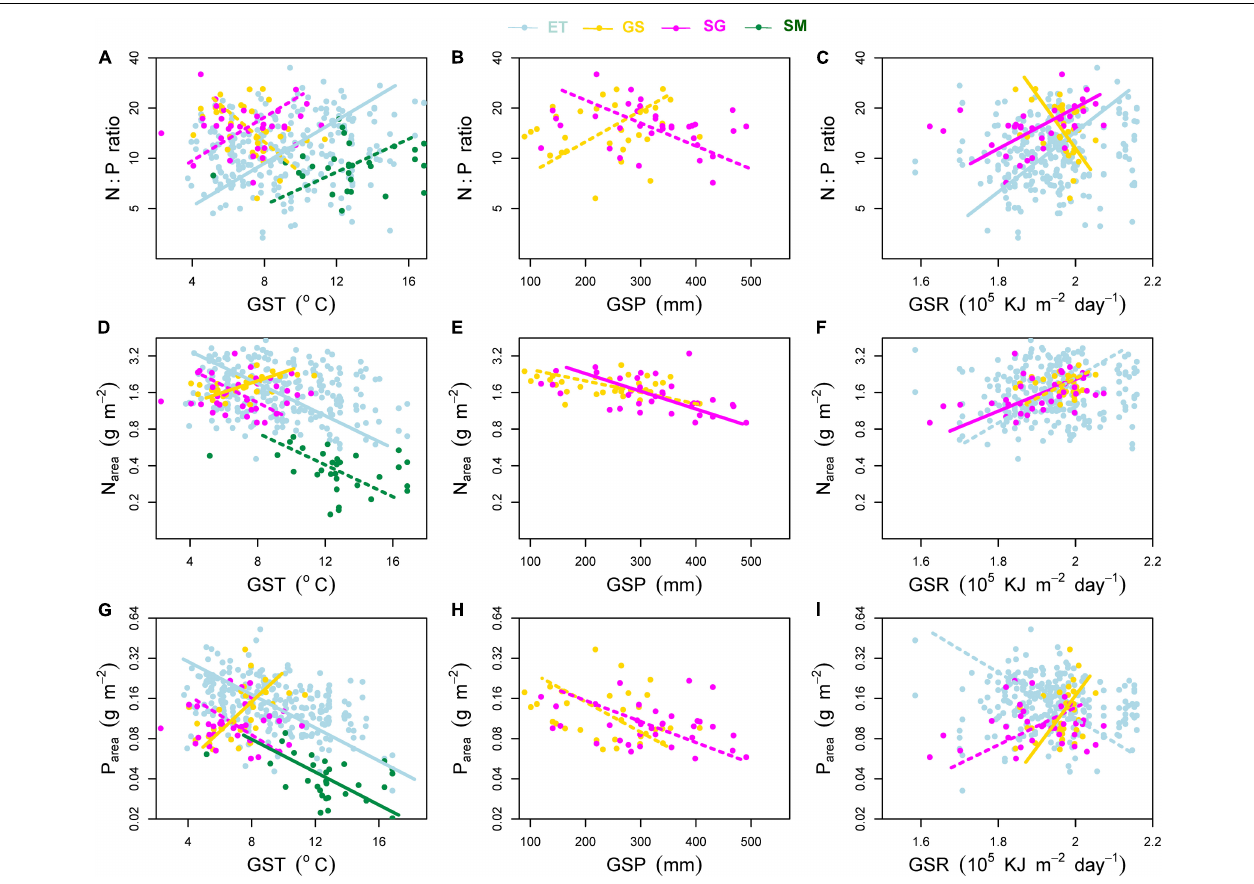
FIGURE 6 | Effects of environmental factors on (A–C) mass-based N:P ratio, (D–F) area-based leaf nitrogen content (N area ) and (G–I) area-based leaf phosphorus content (P area ). Environmental factors include growing season mean air temperature (GST), growing season mean precipitation (GSP), and growing season mean solar radiation (GSR). ET, emergent plants, GS, grasses, SG, sedges, and SM, submerged plants. Solid lines denoted that the environmental factors affected the plant traits significantly at significance level p < 0.05, while the dashed lines showed non-significant